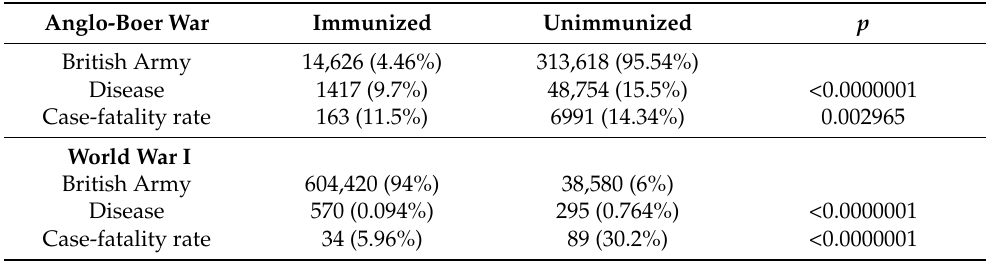
Table 3. Effectiveness of typhoid vaccine in the British Army (Anglo-Boer War, 1899 and World War I,